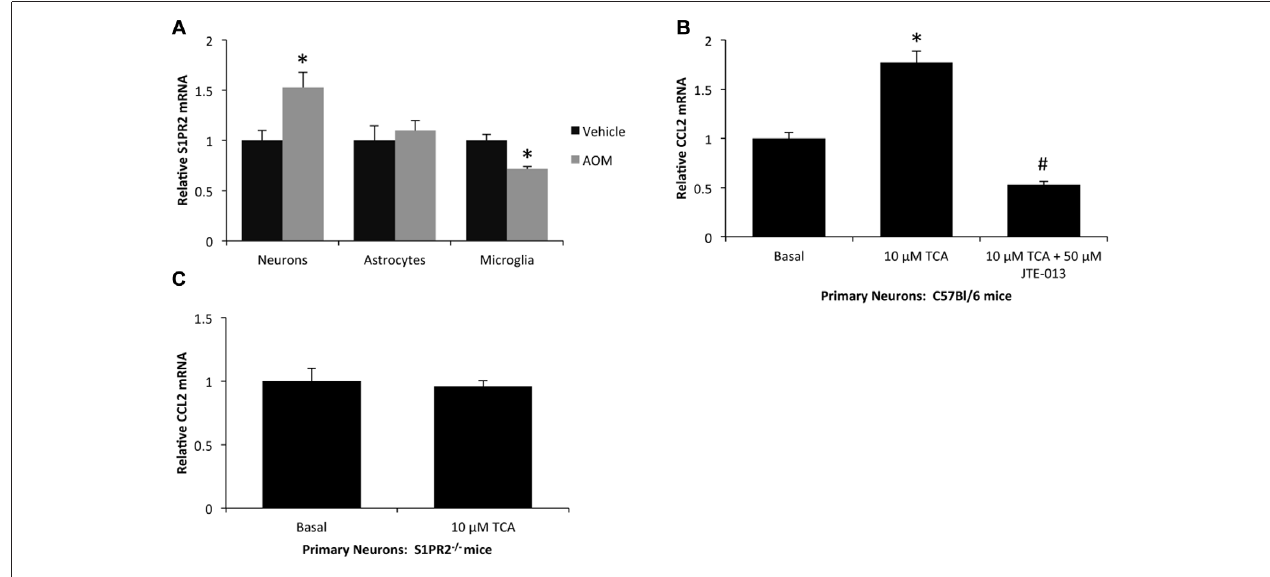
FIGURE 4 | S1PR2 mediates CCL2 expression in primary neurons. (A) Relative S1PR2 mRNA expression in neurons, astrocytes and microglia isolated from vehicle and AOM-treated mice. (B) Relative CCL2 mRNA expression in primary neurons isolated from C57Bl/6 mice that were treated with 10 µ M TCA and/or 50 µ M JTE-013. (C) Relative CCL2 mRNA expression in primary neurons isolated from S1PR2 − / − mice that were treated with 10 µ M TCA. ∗ p < 0.05 compared to basal, # p < 0.05 compared to 10 µ M TCA-treated primary neurons. n = 4 for isolated cell S1PR2 analyses and n = 3 for primary neuron S1PR2 mRNA analyses.